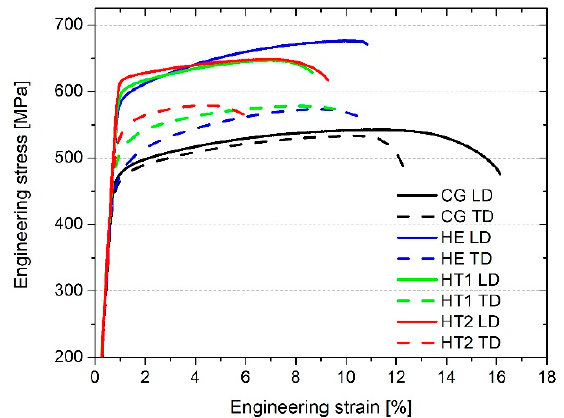
Figure 7. Representative stress–strain curves of the samples.